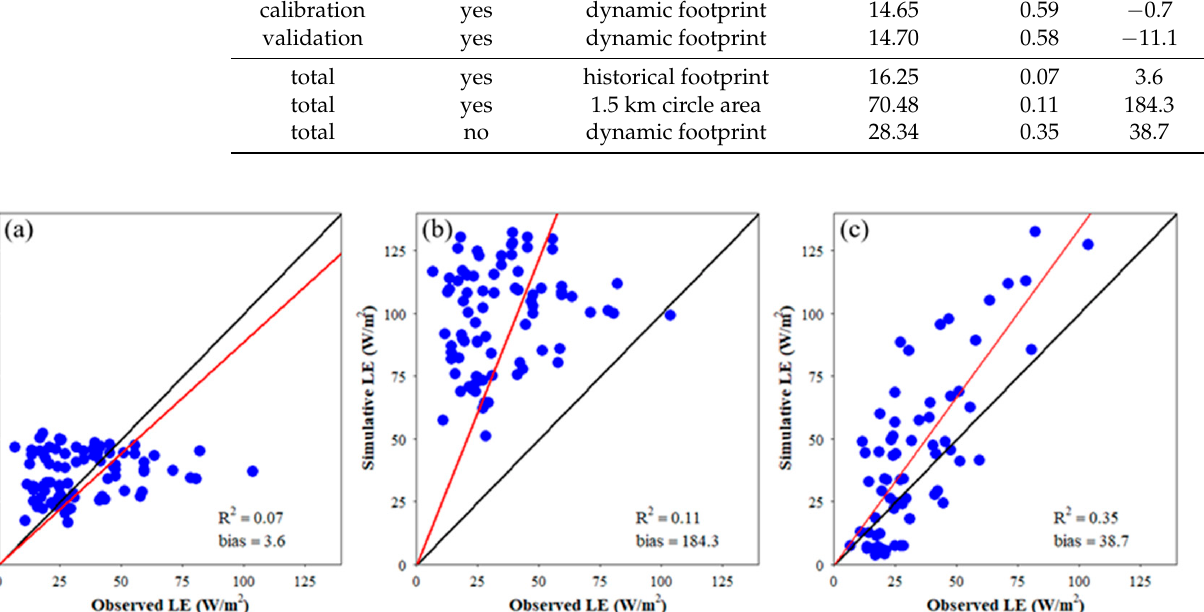
Figure 11. Scatter plots of the observed LE versus the estimated LE ( a ) from the 70% historical footprint average, ( b ) from a 1.0 km radius circle, and ( c ) without considering the shading effects.